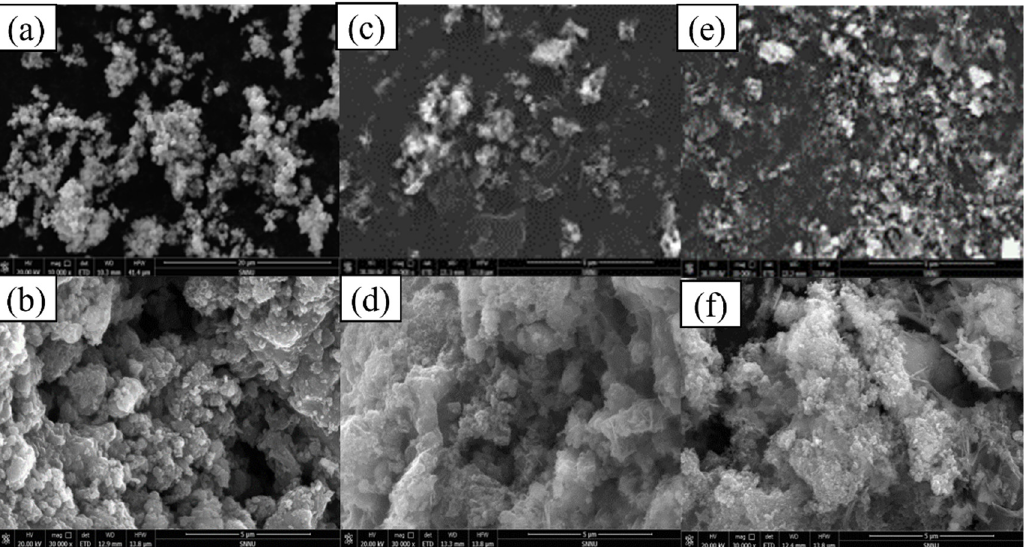
Figure 11. The SEM results of pre- and post-reaction Cr(VI) with supported nZVI. Here, ( a , b ) H 2 A– nZVI; ( c , d ) starch–nZVI; ( e , f )